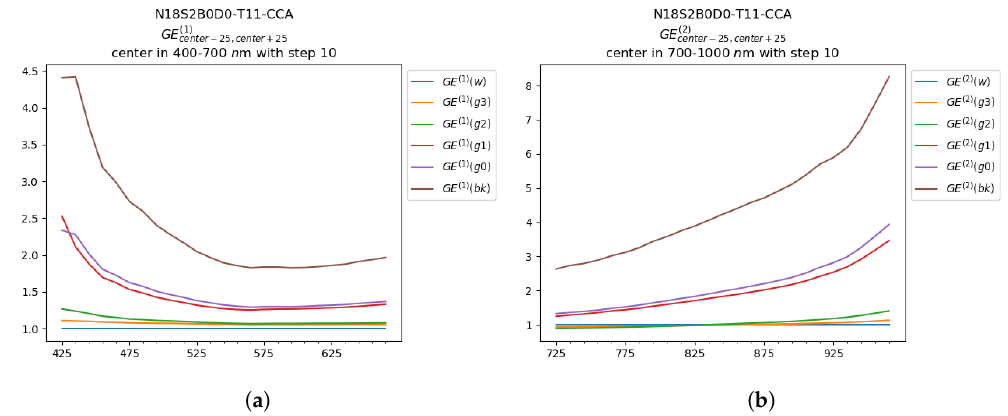
Figure 11. GE ( 2 ) of the CCA of image N18S2B0D0-T11 in ( a ) range 400nm to 700nm and ( b ) in the interval 700nm to 1000nm, both evaluated for each wavelength and smoothed by applying a sliding